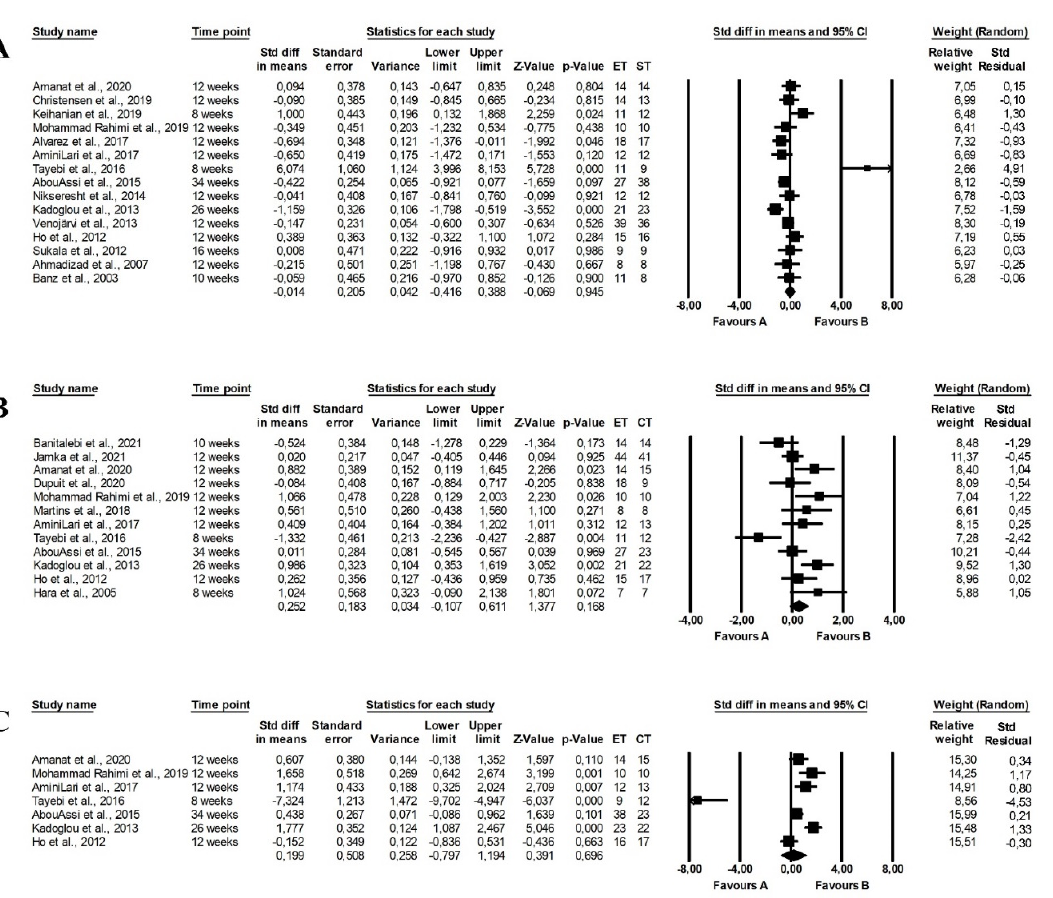
Figure 3. Forest plots of the effect of training programmes on insulin levels: ( A ) endurance (favours A) vs. strength (favours B) training (random model) [16,20,41,44–46,50,51,58,63,65,66,68,71,73]; ( B )